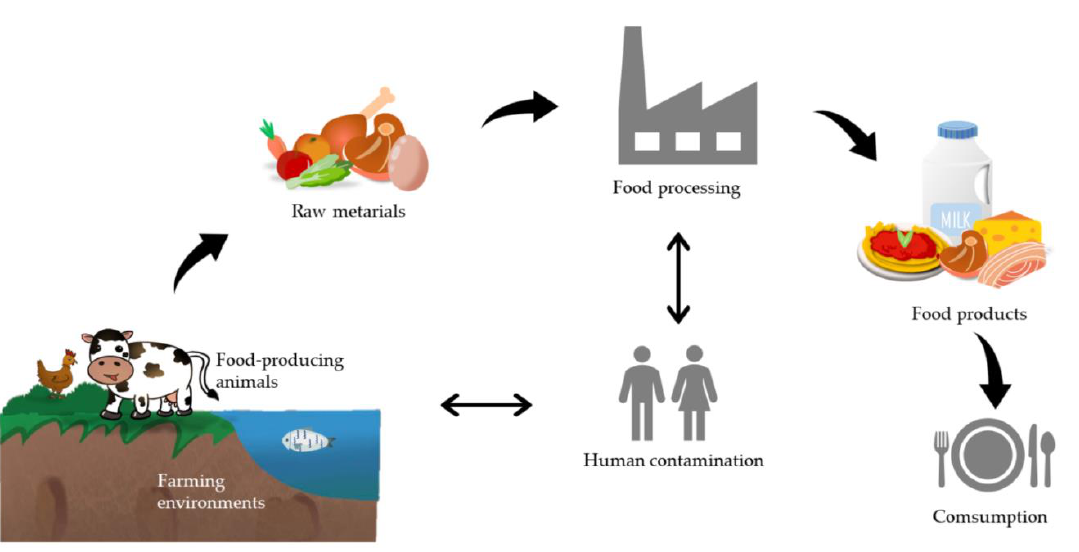
Figure 1. The possible sources of foodborne pathogens. Every step from farm to table can ultimately lead to foodborne diseases, including polluted farming environments, diseased food-producing animals, contaminated raw materials, non-hygienic food processing, and non-hygienic food consumption. In this process, food handlers can cause (post-processing) contamination, which they can also acquire themselves from animals or in the food processing environment even though the latter is less likely. The review focuses on persister-cells of various Escherichia coli (EPEC, EHEC, STEC, EIEC, EAEC, ETEC), Salmonella , and Listeria species both in food and upon human infection. For the major bacterial cause of gastroenteritis, Campylobacter jejuni , data on persister-cells is emerging but still scarce. Staphylococcus aureus and Bacillus cereus are considered human and animal contaminants of the food chain with the former being present on the skin of food handlers and the latter originating from spores present in the environment.